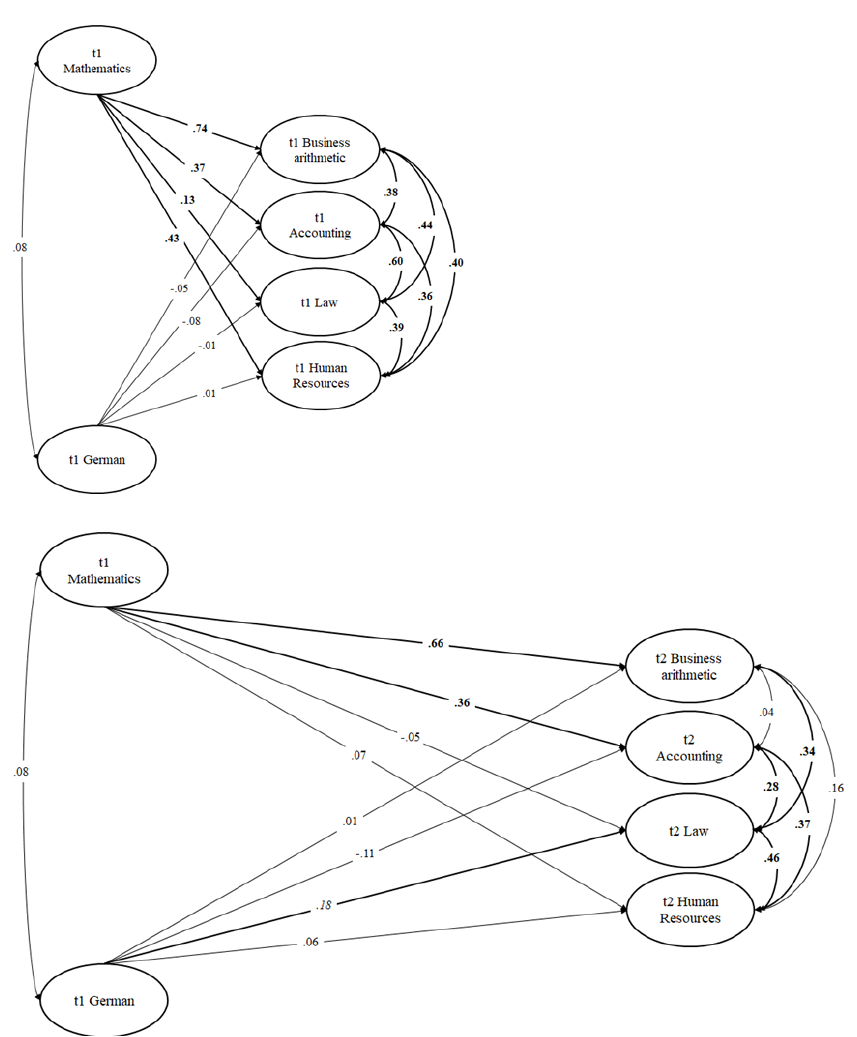
Figure 1. Results from structural equation models regarding self-concepts of ability. Note . The figure shows standardized coefficients; significant paths/correlations and coefficients are printed in bold ( p < .05), marginally significant coefficients ( p < .10) are printed in italics; for further description, see